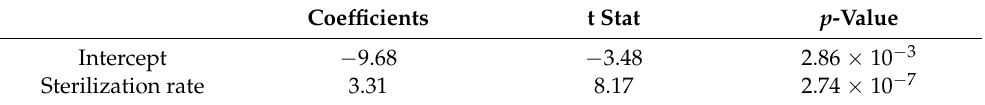
Table 3. Multiple regression analysis between VRE sterilization rates and electrical